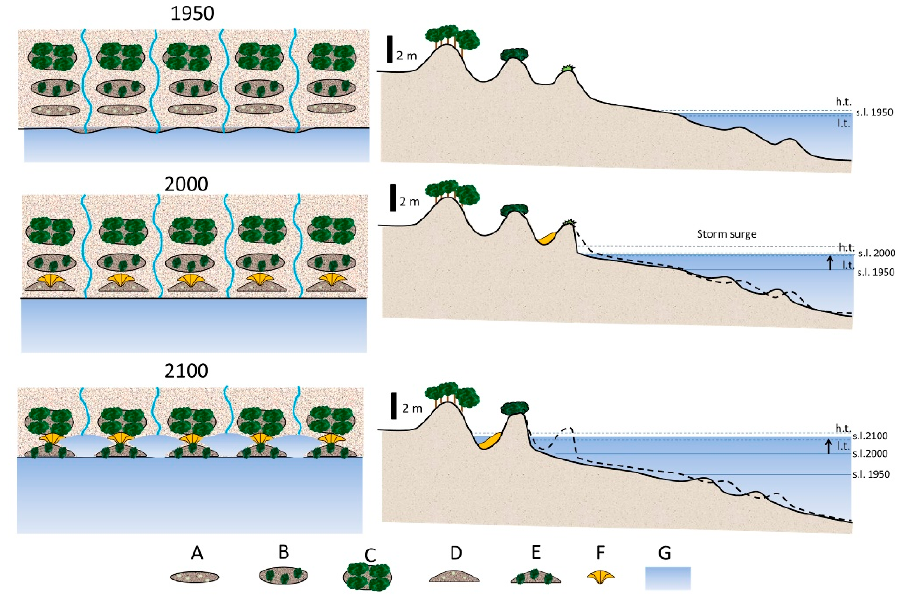
Figure 15. The conceptual model for coastal submersion in function of the mean sea-level rise, and changes in foreshore between high tide (h.t.) and low tide (l.t.). A—Primary Dune Ridge;